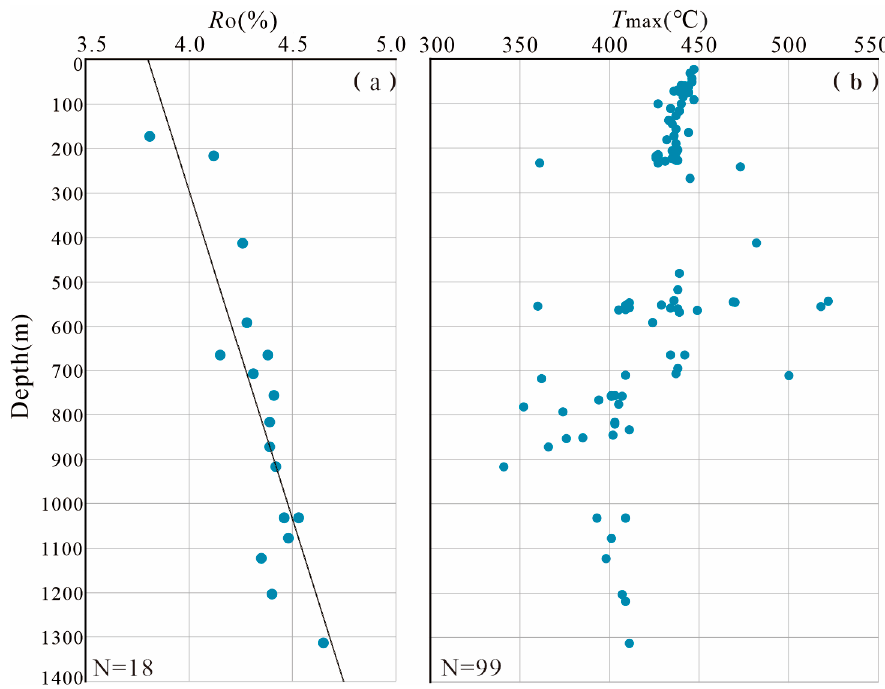
Figure 3. Evolution trend of source-rock samples of the Laiyang Formation in well LK-1: ( a ) Chart of R o with depth; ( b ) Chart of T max with depth.